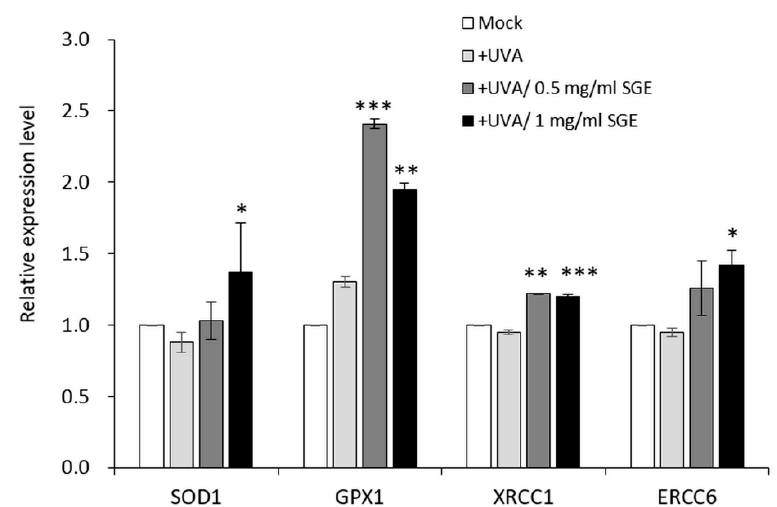
Figure 4. SGE extracts induced antioxidant gene expressions in CCD-966SK cells after UVA irradiation. Cells were pretreated with UVA for 1 hour (+UVA, light grey bar), and then treated with 0.5 or 1 mg/ml of SGE (dark grey and black bars), or left untreated as a negative control (Mock, white bar). Cells were harvested for total RNA isolation and expression detection for SOD1 , GPX1 , XRCC1 and ERCC6 . *, P < 0.05 versus +UVA; **, P < 0.01 versus +UVA; ***, P < 0.001 versus +UVA. SGE, Sargassum glaucescens extracts.